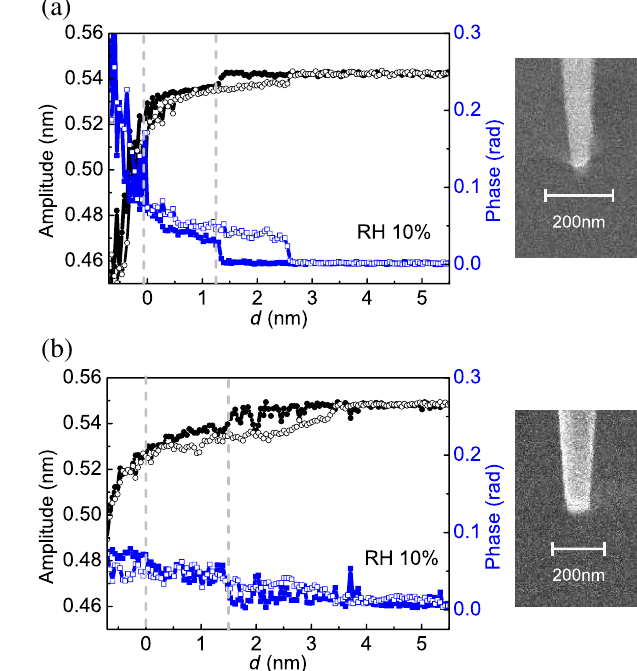
FIG. 10. Comparison of the critical distance depending on the mica preparation method. Panels (a), (c), and (e) are the typical approach-retraction curves above the tape-cleaved mica surface at differing RH. The corresponding panels [(b), (d), and (f)] are the approach-retraction curves on the mica that was rinsed with dilute aqueous solutions of HCl (pH ∼ 3 ) for 2 minutes and then dried with a stream of nitrogen gas as in Ref. [14]. The same tip was used in both cases. As is clear, capillary condensation above the rinsed mica surface clearly shows larger critical distances.